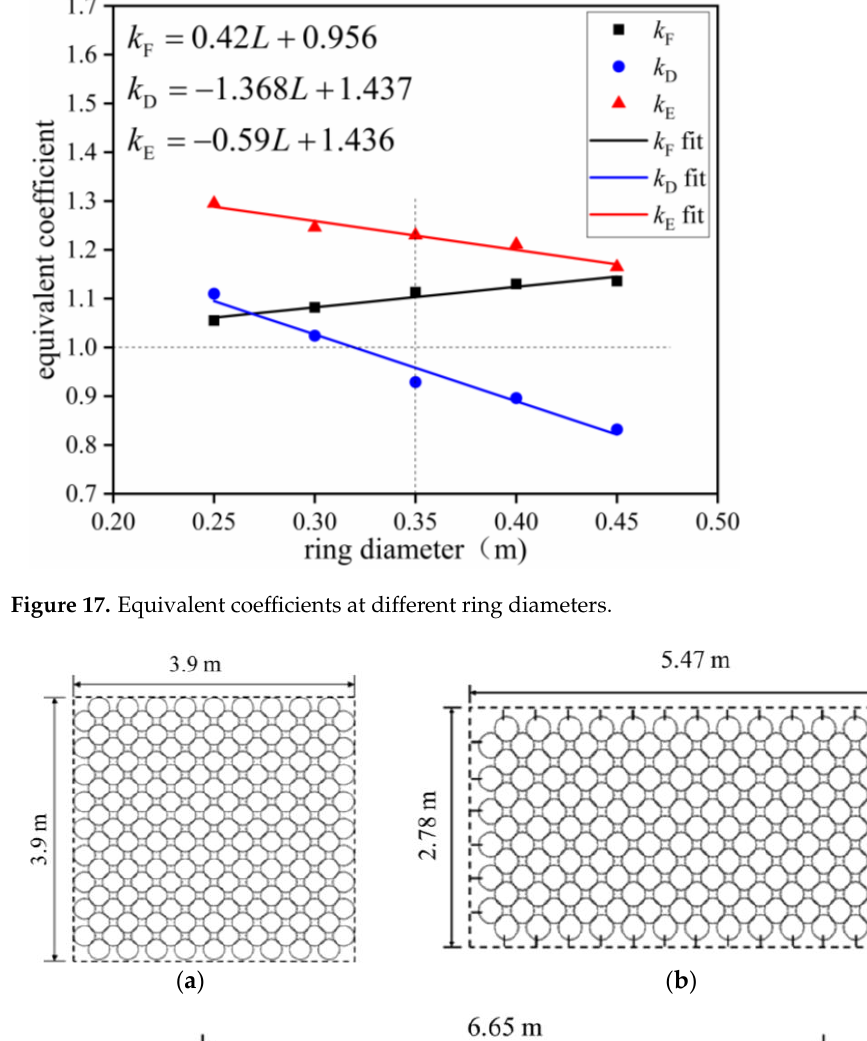
Figure 18. Ring net models with different ring network aspect ratios: ( a ) ring net aspect ratio of 1:1; ( b ) ring net aspect ratio of 2:1; ( c ) ring net aspect ratio of 3:1.